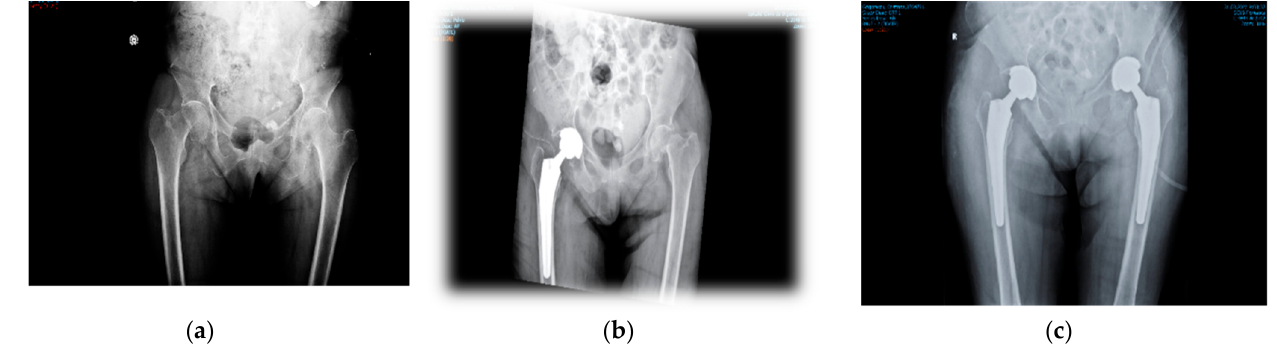
Figure 5. Case 1: X-ray radiographs. ( a ) The R femoral neck fracture is visible initially, but not the L one. ( b ) R femoral neck fracture reduced with prosthesis. The L crack is revealed in surgery. ( c ) The L femoral neck fracture is fixed with prosthesis seven days post R-side surgery.